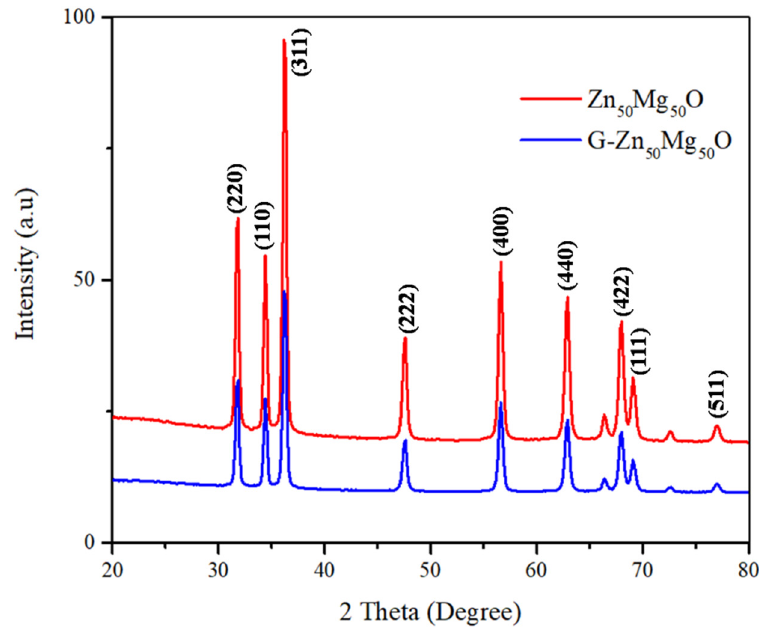
Figure 1. XRD spectra of Zn 50 Mg 50 O and G-Zn 50 Mg 50 O.